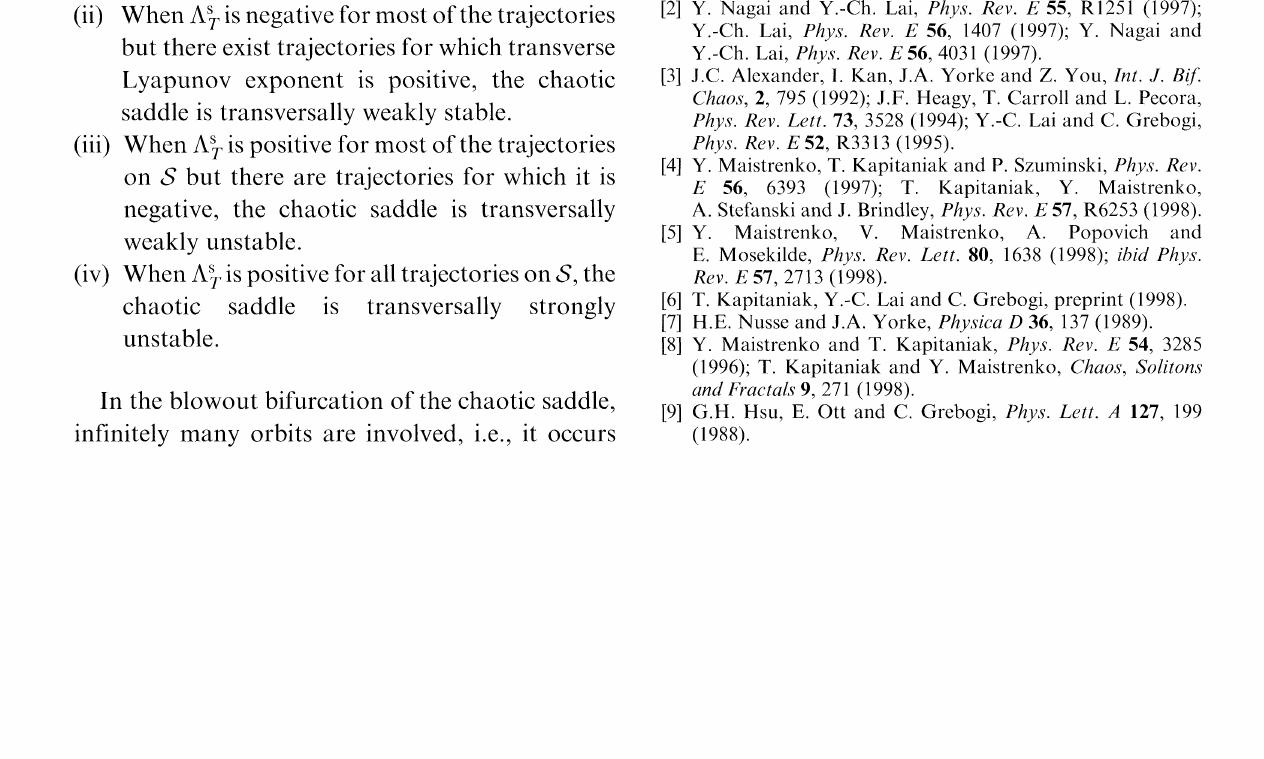
FIGURE 3 Detailed structure of the chaotic saddle after the blowout bifurcation (enlargements of Fig.